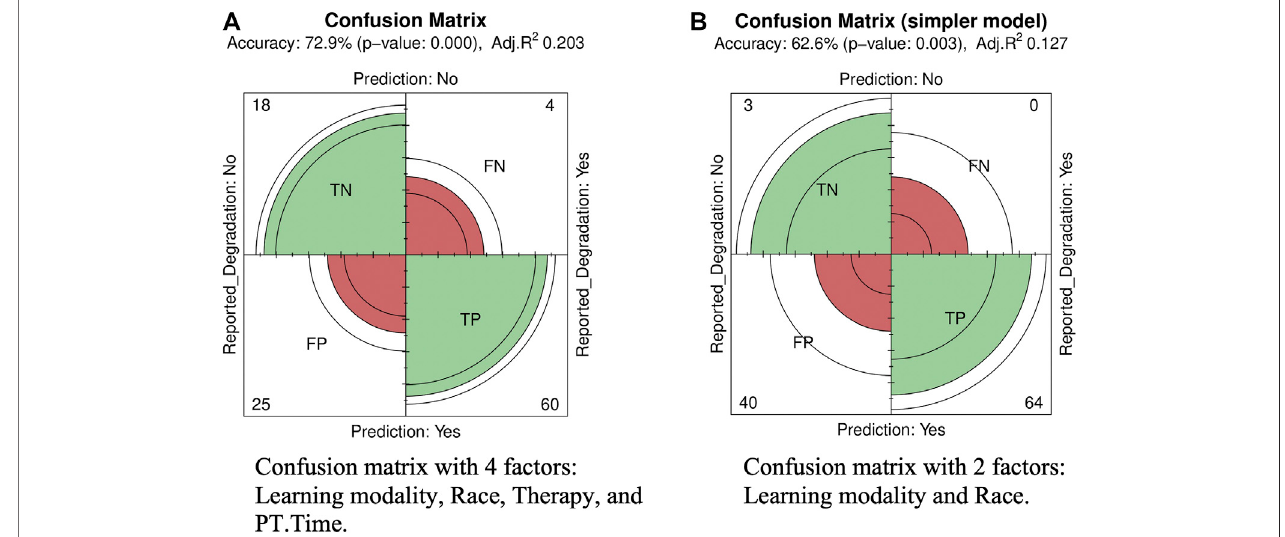
FIGURE8| Confusionmatrixtocomparetheeffectivenessofaregressionmodelusingjusttwoexplanatoryvariables,namely:learning-modality(In-personvs.online) and Race. (A) Confusion matrix with 4 factors: Learning modality, Race, Therapy, and PT. Time. (B) Confusion matrix with just 2 factors: Learning modality and